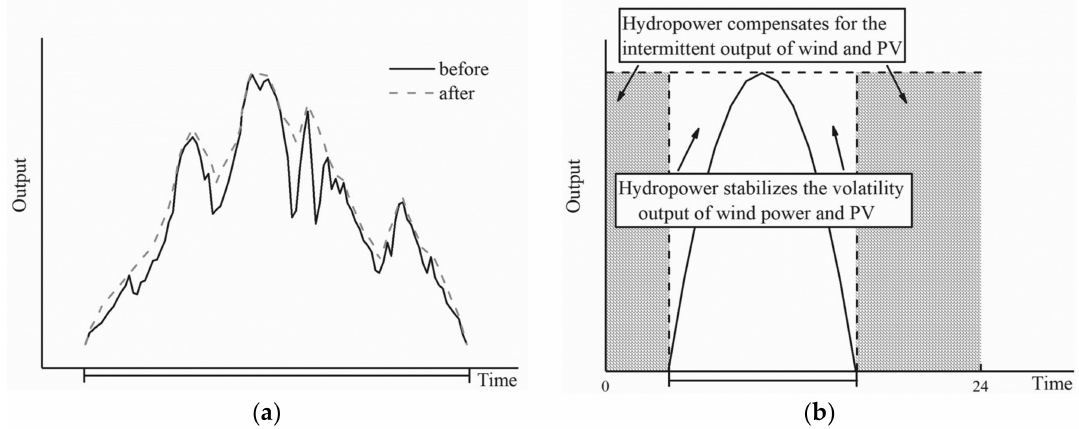
Figure 2. Hydropower compensation for wind power and photovoltaic: ( a ) Volatility compensation; ( b ) Intermittent